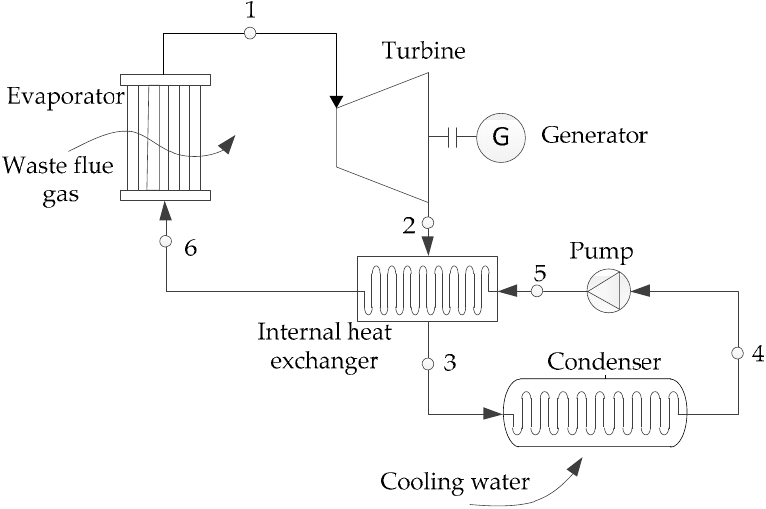
Figure 1. Schematic diagram of the regenerative Organic Rankine Cycle (ORC) system for low-temperature waste heat.